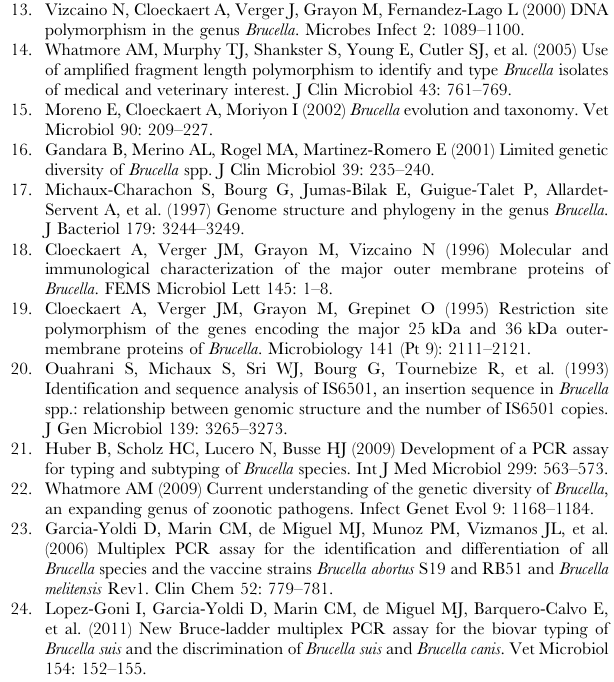
Figure 1. Dendrogram derived from the MLVA-16 genotyping assay. This dendrogram illustrates the various relationships among the 29 Chinese B. canis isolates and the 38 non-Chinese B. canis strains. In the columns, the following data for isolates are indicated: Strain: laboratory identifier of isolate in which the DNA extraction was performed, No. genotype numbering, Place/Year: country and year of isolation (when known), MLVA-8: genotype numbers associated with the genotypes corresponding to each isolates in the